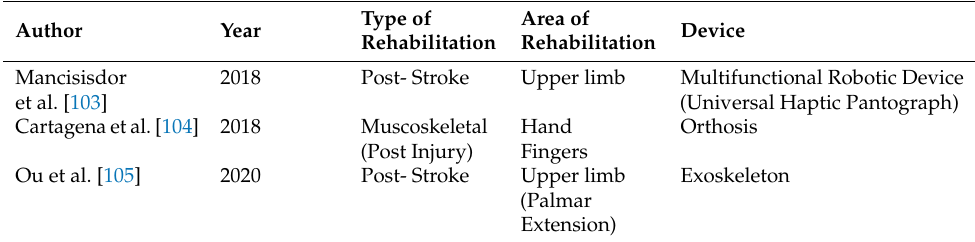
Table 7. BCI for virtual rehabilitation with assistive